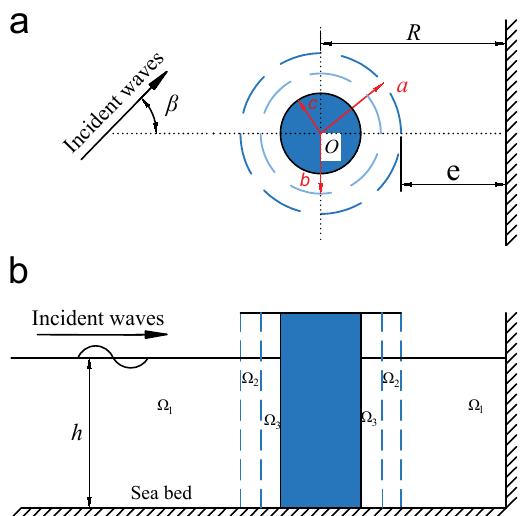
Figure 1. Definition sketch: ( a ) plane view; ( b ) side